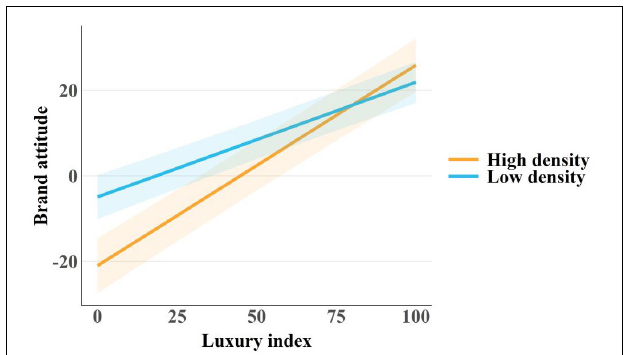
FIGURE 1 | Shaded areas around slopes show 95% confidence intervals. Higher scores on the Y -axis correspond to more positive attitudes toward brands, whereas higher scores on the X -axis denote brands deemed more